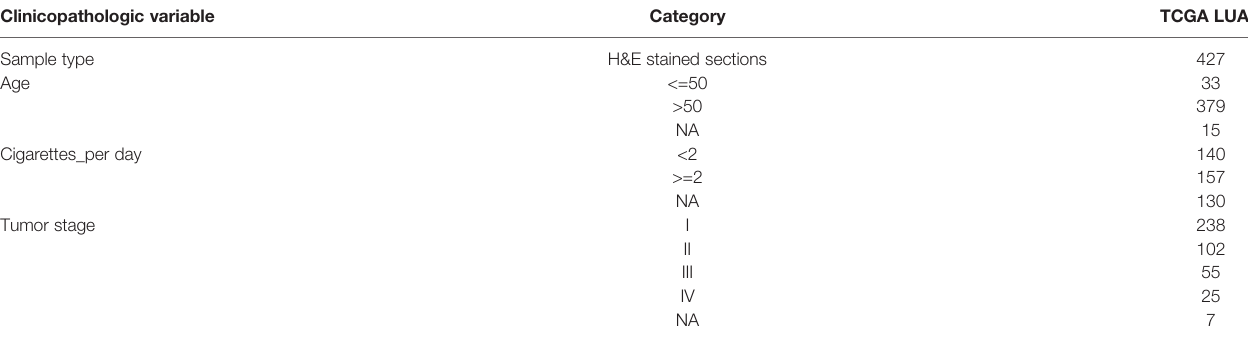
TABLE 1 | Summary of the general clinical information of patients with lung adenocarcinoma. Clinicopathologic